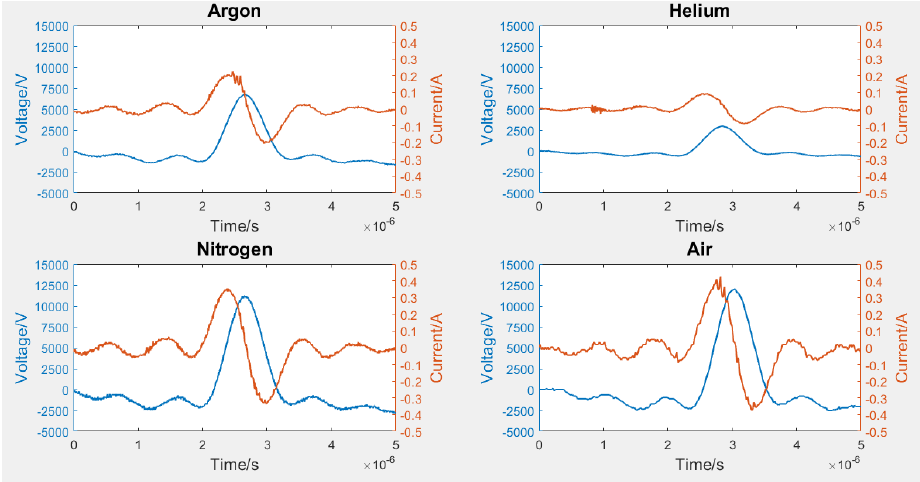
Figure 2. Current and voltage curves of the plasma source, each operated at the ignition limit with different process gases. Table 1. Overview of electrical parameters of DBDs generated with different process gases. Electrical